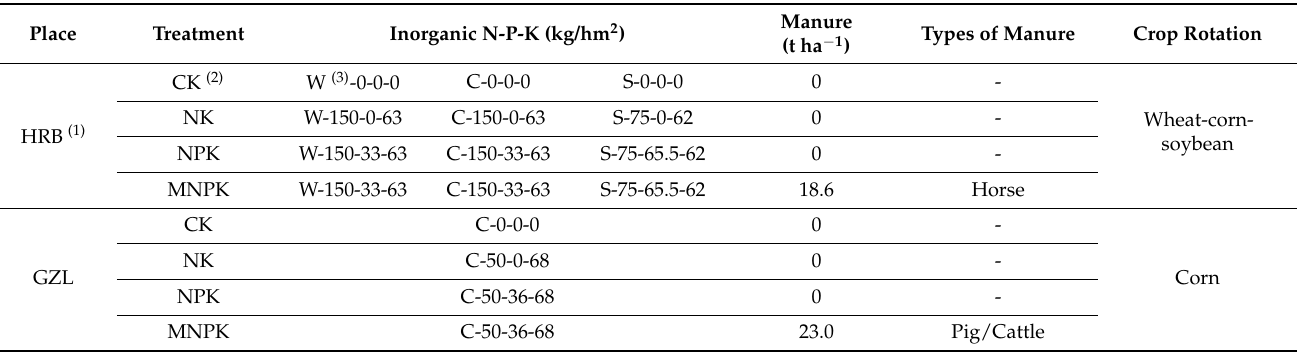
Table 3. Fertilizer input and crop